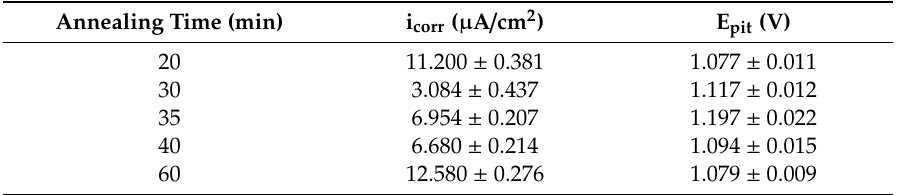
Table 5. Corrosion current density and pitting potential values (average ± standard deviation) of S32750 stainless steel with di ff erent annealing times. The average and standard deviation values were obtained from 5 experiments.